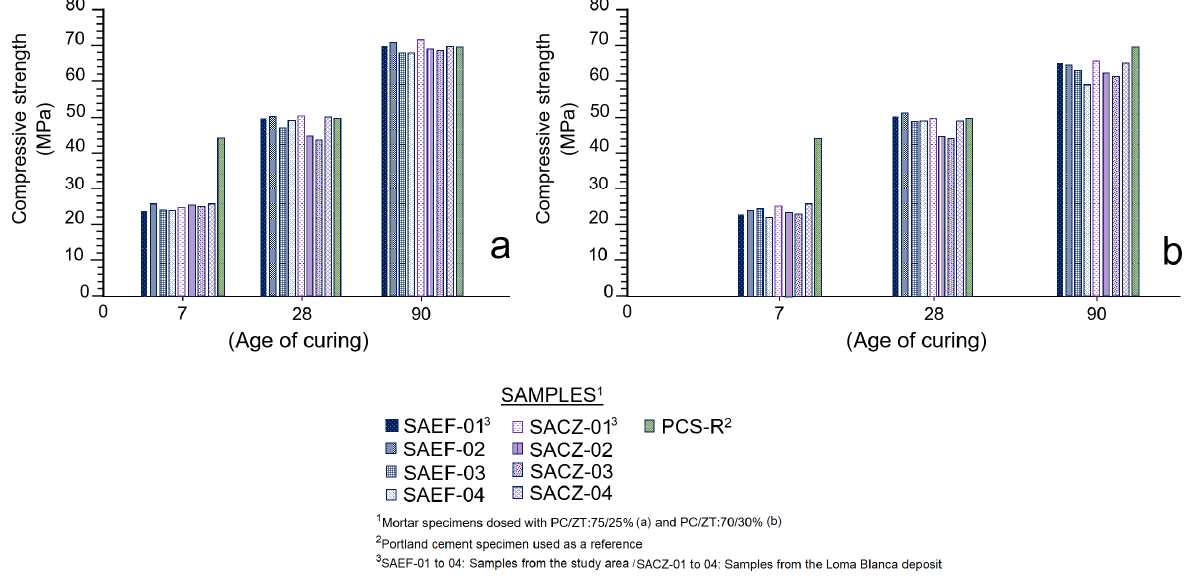
Figure 5. Mechanical compressive strength determined for specimens manufactured with PCS-R and PC/ZT at 7, 28, and 90 days of curing. Graph ( a ) shows the mechanical behaviour of the specimens manufactured with the dosage PC/ZT: 75–25%, and graph ( b ) shows the mechanical behaviour of the specimens manufactured with the dosage PC/ZT: 70–30%.